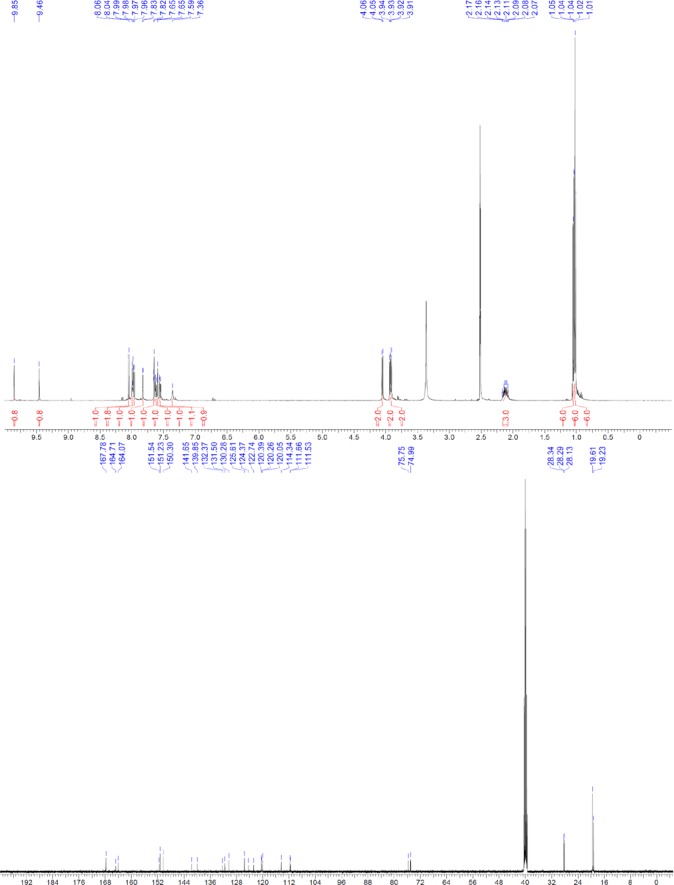
1H and 13C NMR of ERX-5.